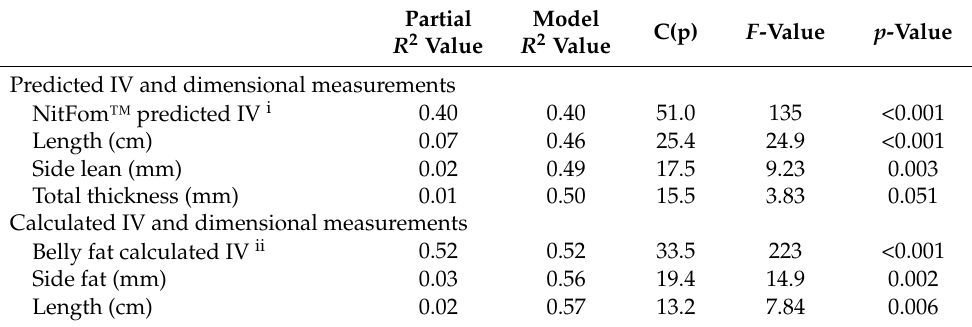
Table 2. Iodine value (IV) and dimensional measurement contributions to predicting belly bend angle using stepwise regression